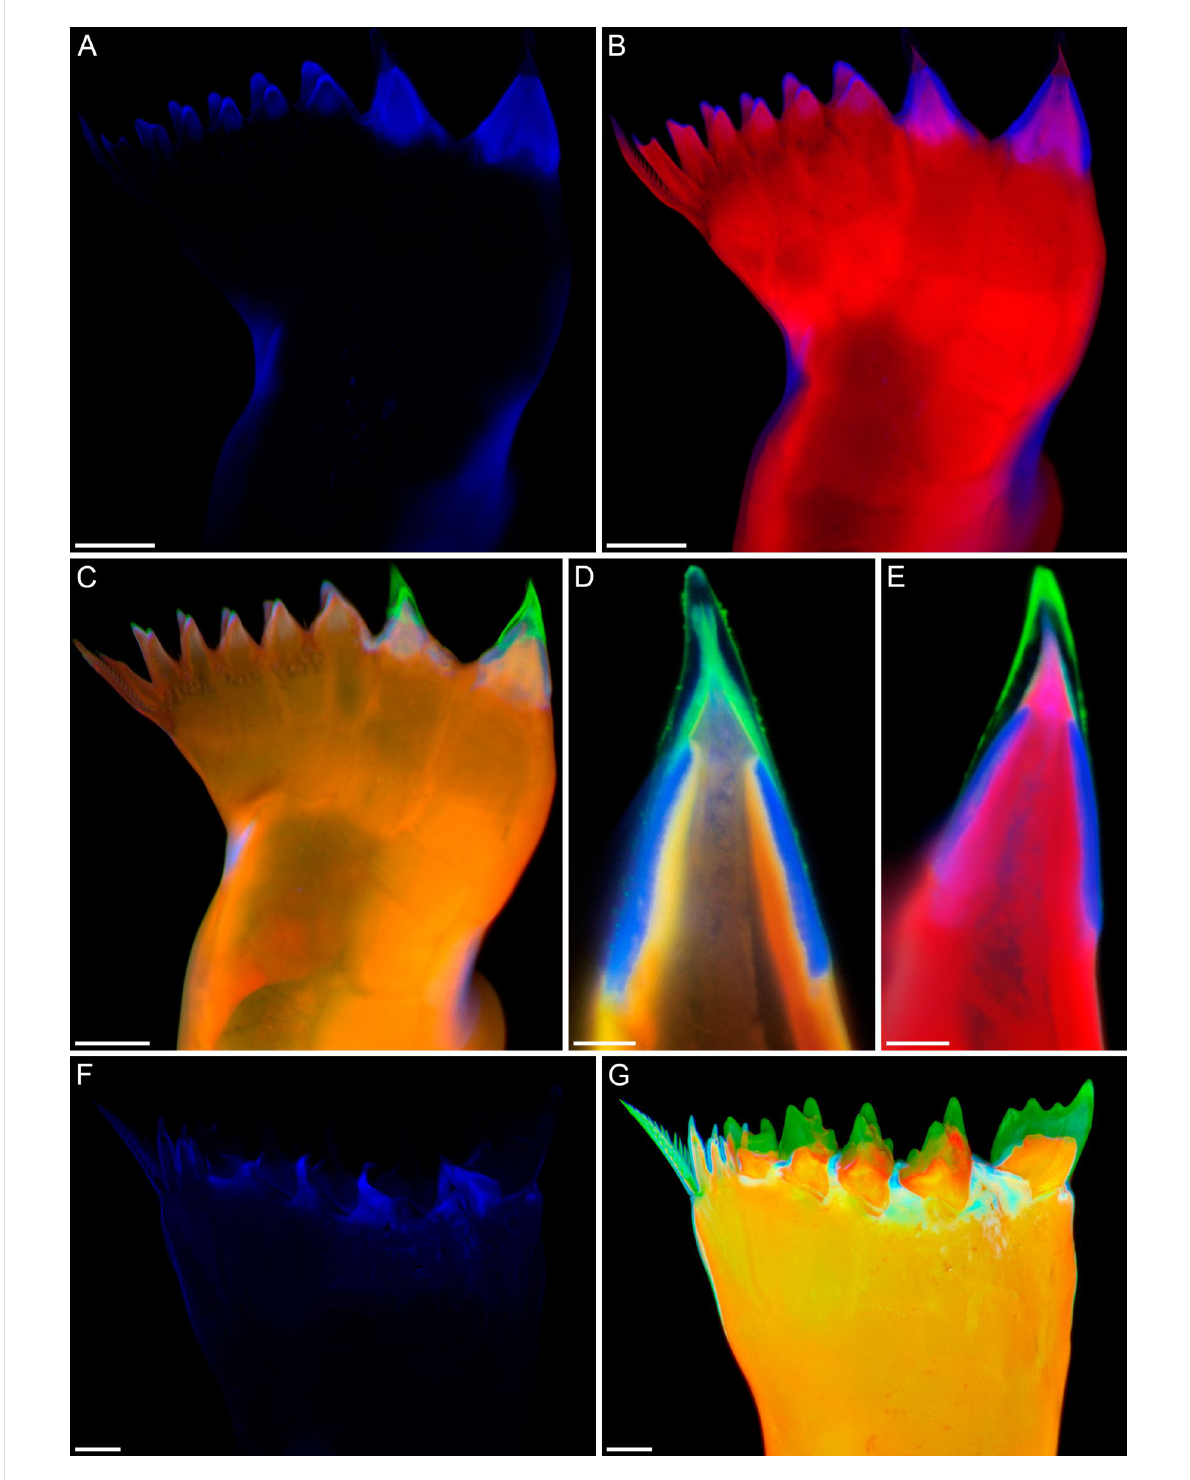
Figure 7: Morphology and material composition of mandibular gnathobases of copepods. Confocal laser scanning micrographs showing gnathobase structures of (A–E) a female of the copepod species Centropages hamatus and (F, G) a female of the copepod species Rhincalanus gigas . (A–C, F, G) Maximum intensity projections. (D, E) 1 µm thick optical sections through the largest tooth of the gnathobase. (A, F) Distribution of resilin. (B) Chitinous exoskeleton (red) and resilin-dominated structures (blue). (C–E, G) Chitinous exoskeleton (red, orange), resilin-dominated structures (blue, light blue, turquoise) and silica-containing structures (green). Scale bars = 20 µm (A, B, C), 5 µm (D, E), 25 µm (F, G). (A–E) Adapted with permission from [29]. (F, G) Adapted with permission from [30], copyright 2015